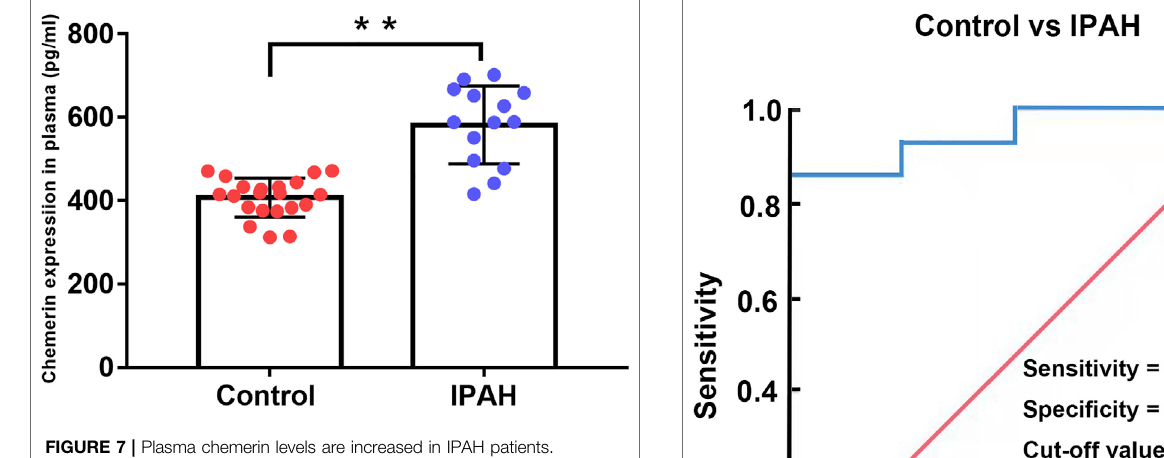
FIGURE 7 | Plasma chemerin levels are increased in IPAH patients. HumanplasmachemerinproteinlevelsweremeasuredbyELISAinthecontrol and IPAH groups. Quantitative analysis of chemerin protein expression in the plasmaofeachgroupwasalsoperformed(control, n =21;IPAH, n =14). ** p ＜ 0.01 vs. the control group.